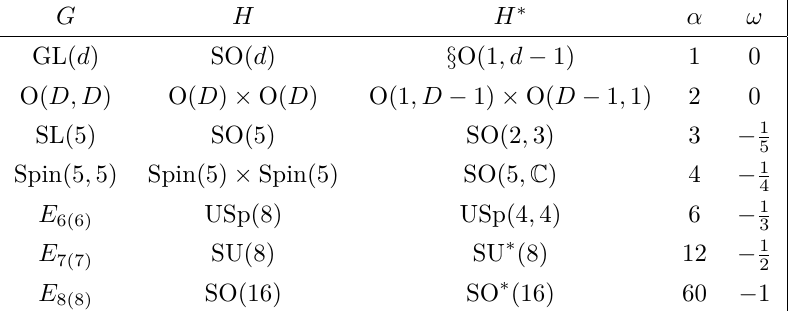
Table 1 . List of duality groups G and their maximal compact subgroups H (Euclidean case) and H ∗ (Lorentzian